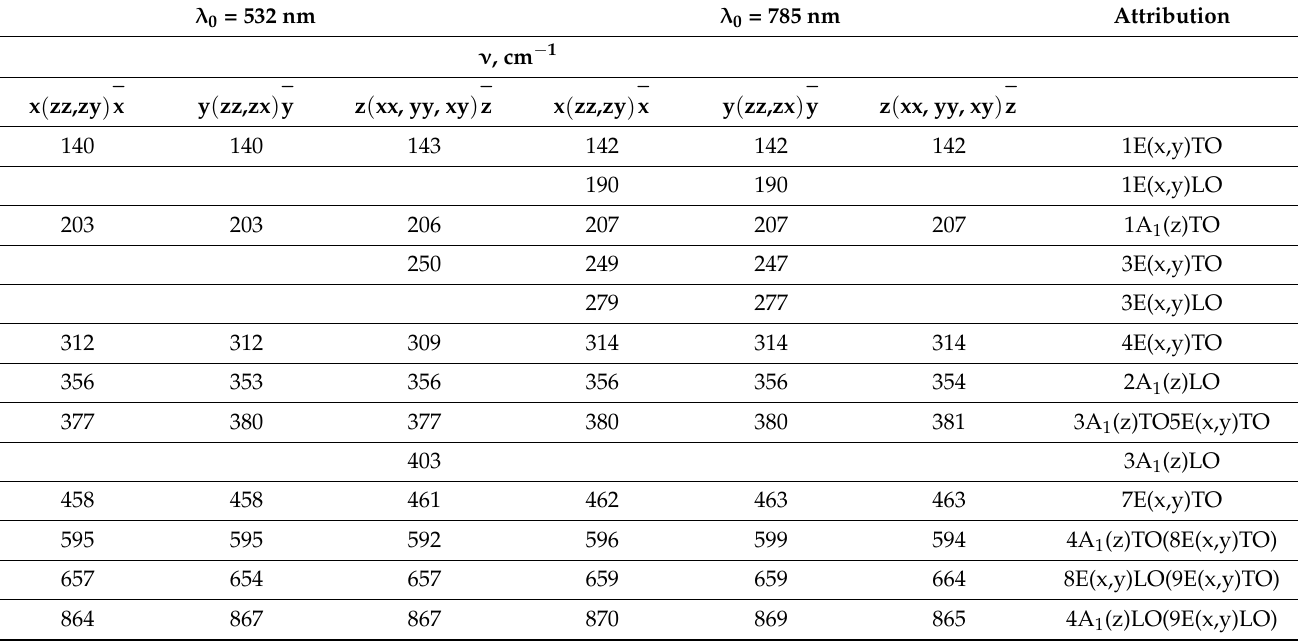
Table 2. Real frequencies of polar vibrations (both transverse (TO) and longitudinal (LO)) of the LT:Cr crystal obtained in this study, and their